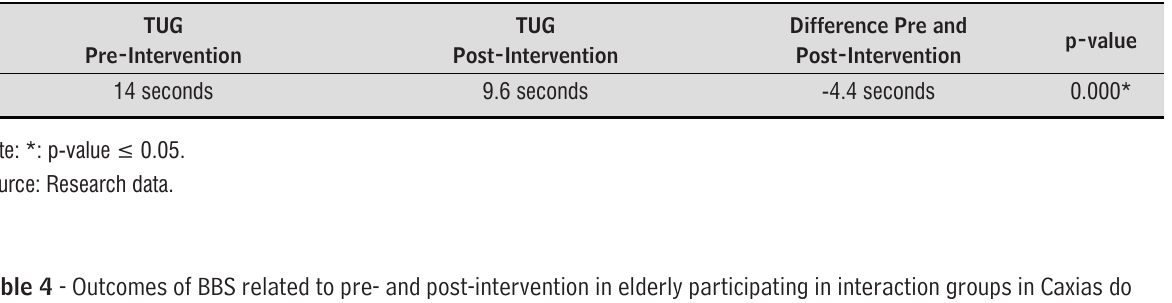
Table 4 - Outcomes of BBS related to pre- and post-intervention in elderly participating in interaction groups in Caxias do Sul City, RS State,